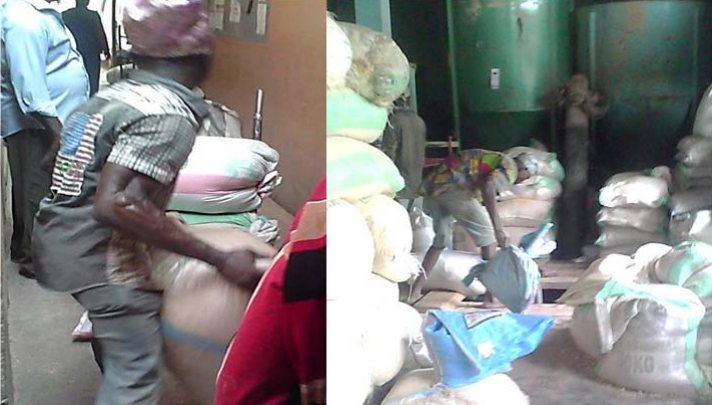
Figure 7. Manual material handling operation; loading hand truck (left), conveying materials during milling (right).